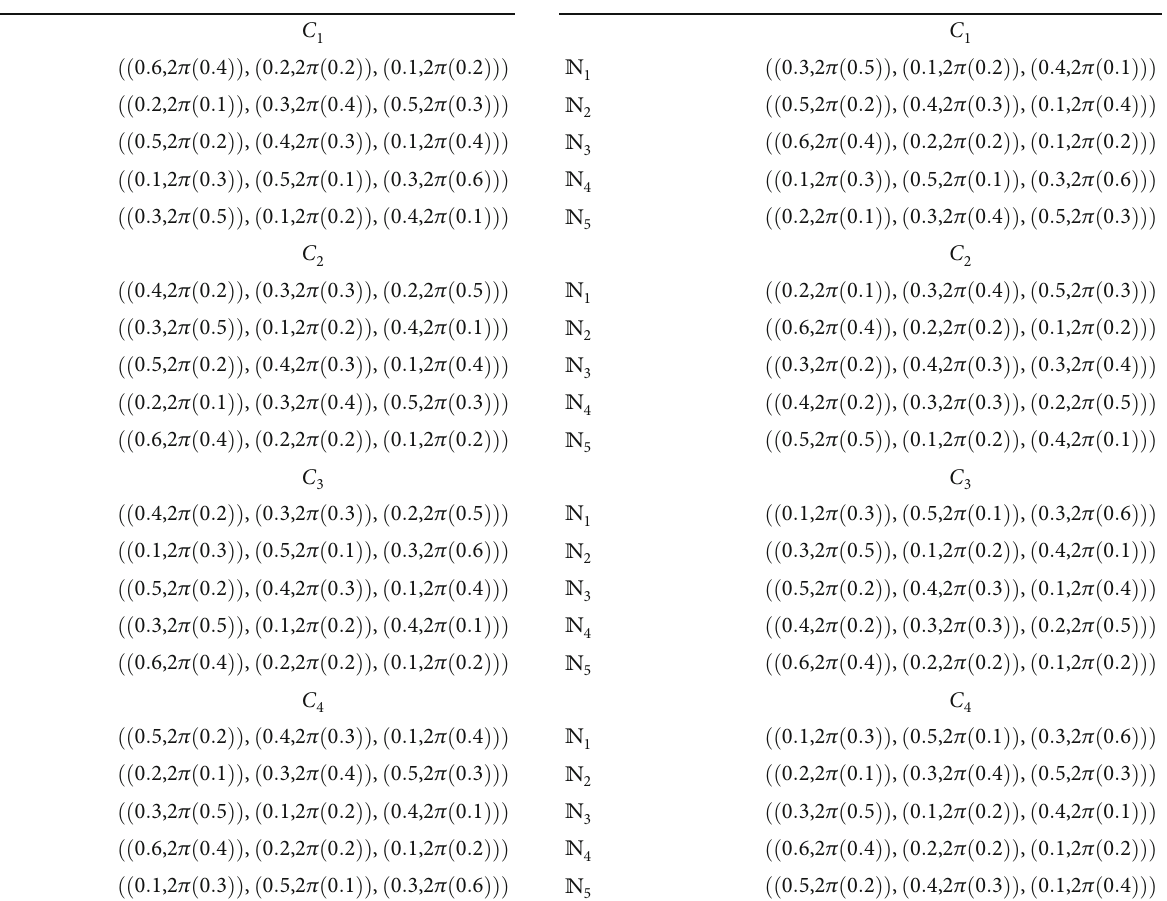
Table 1: Preferences for alternatives provided by expert E ð 1 Þ :